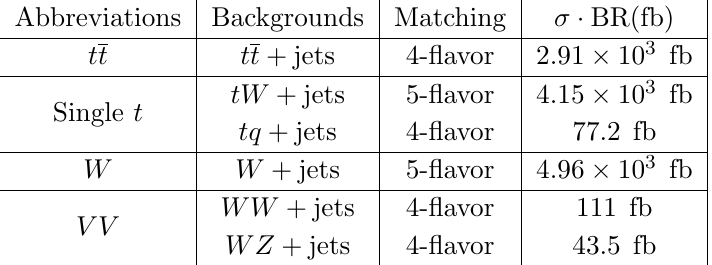
BR denotes the production cross (cid:1)